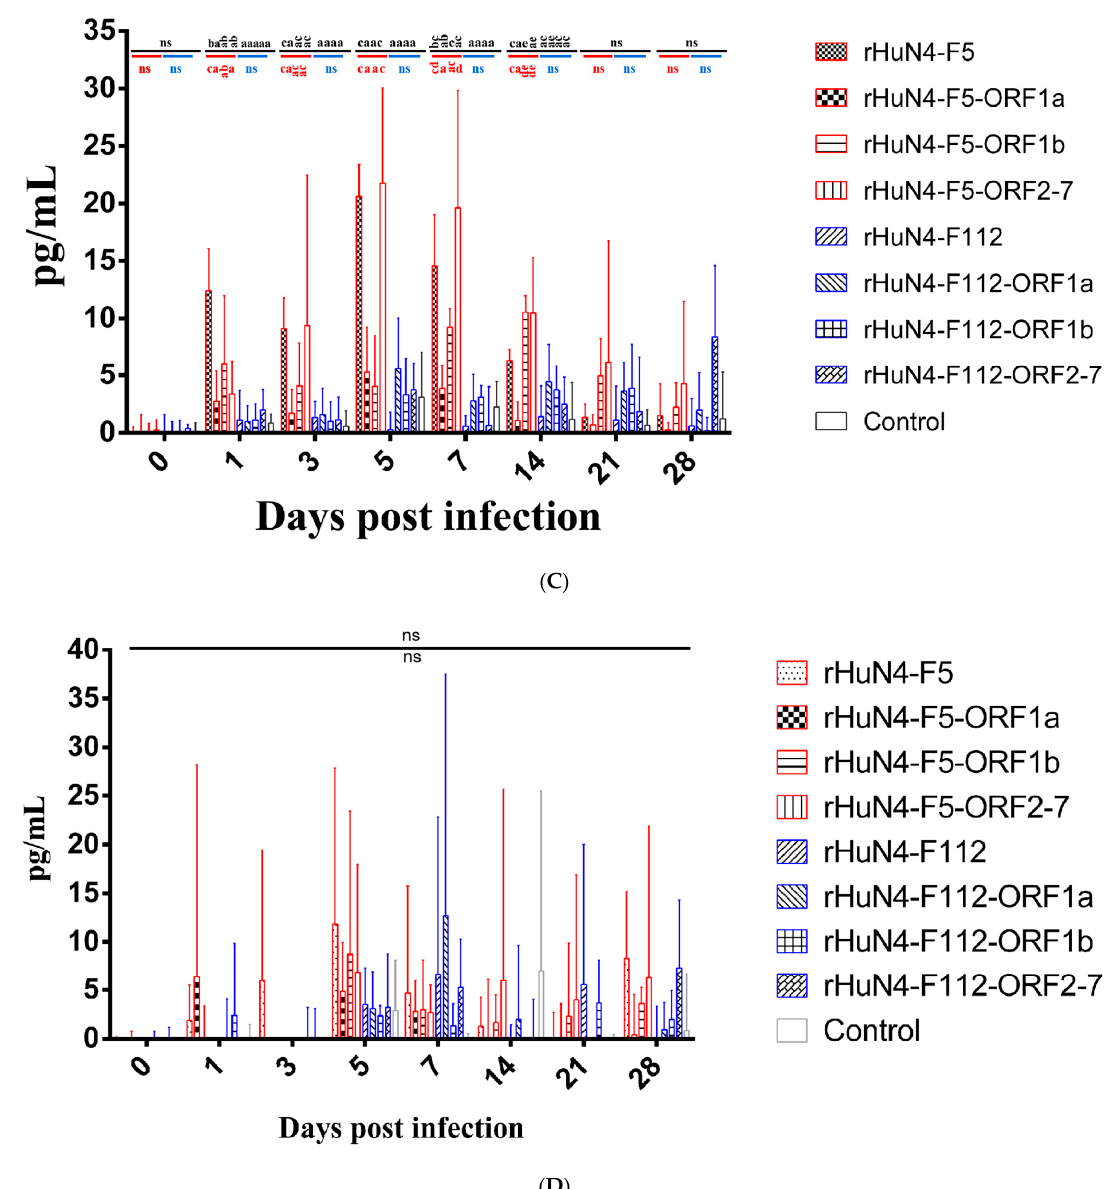
Figure 5. Cytokine response of each group. ( A ) IL-1 β response in peripheral blood after infection. ( B ) IL-6 response in peripheral blood after infection. ( C ) IL-10 response in peripheral blood after infection. ( D ) IFN- γ response in peripheral blood after infection. Chimeric viruses with HuN4 backbone were showed with red border, Chimeric virus with HuN4-F112 backbone were showed with blue border. The results of cytokines among all the groups were showed in black alphabets above the black line, the results of rHuN4-F5 and chimeric viruses with rHuN4-F5 backbone were showed in red alphabets below the red line, the results of rHuN4-F5 and chimeric viruses with rHuN4-F5 backbone were showed in blue alphabets below the blue line. Results were showed with single alphabet, or a range of alphabets which were represented by the first and last alphabet. The results which share same alphabet or showed as “ns” means p ≥ 0.05; results do not share same alphabet but have adjacent alphabets with each other means p < 0.05; results do not share same alphabet or adjacent alphabets with each other means p < 0.01. Results among all the viruses were showed with black alphabets above the line, results among HuN4-F5 backbone chimeric viruses were showed with red alphabets below the line, and results among HuN4-F112 backbone chimeric viruses were showed with light blue alphabets below the